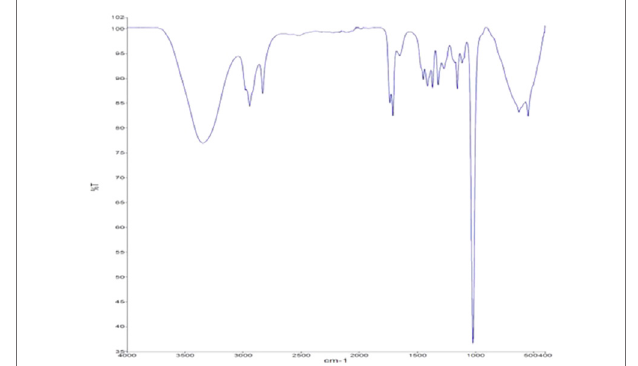
FIGURE 9 | FTIR characterization of biodiesel from